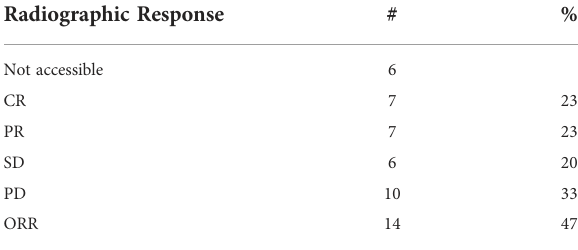
TABLE 4 Objective response rate (ORR) of patients with mucosal melanoma treated with neoadjuvant checkpoint